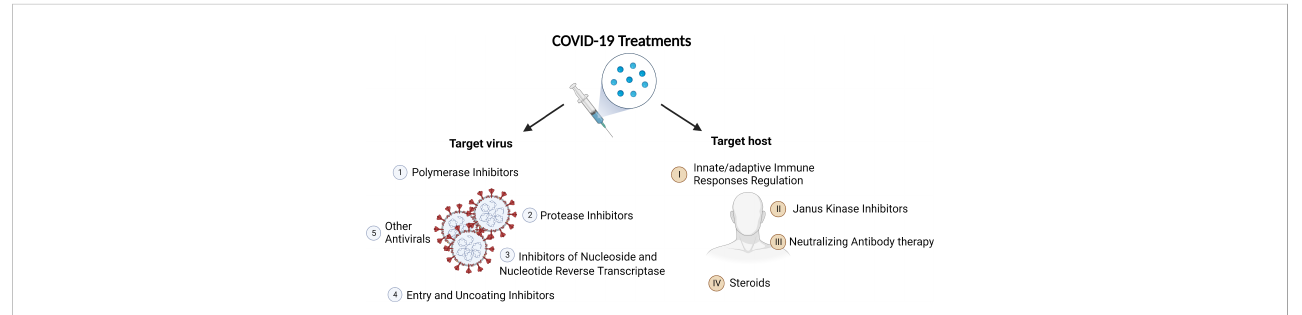
FIGURE 1 Category of COVID-19 treatments. On the basis of their targets, the treatments can be divided into two big categories: antiviral agents and therapies targeting